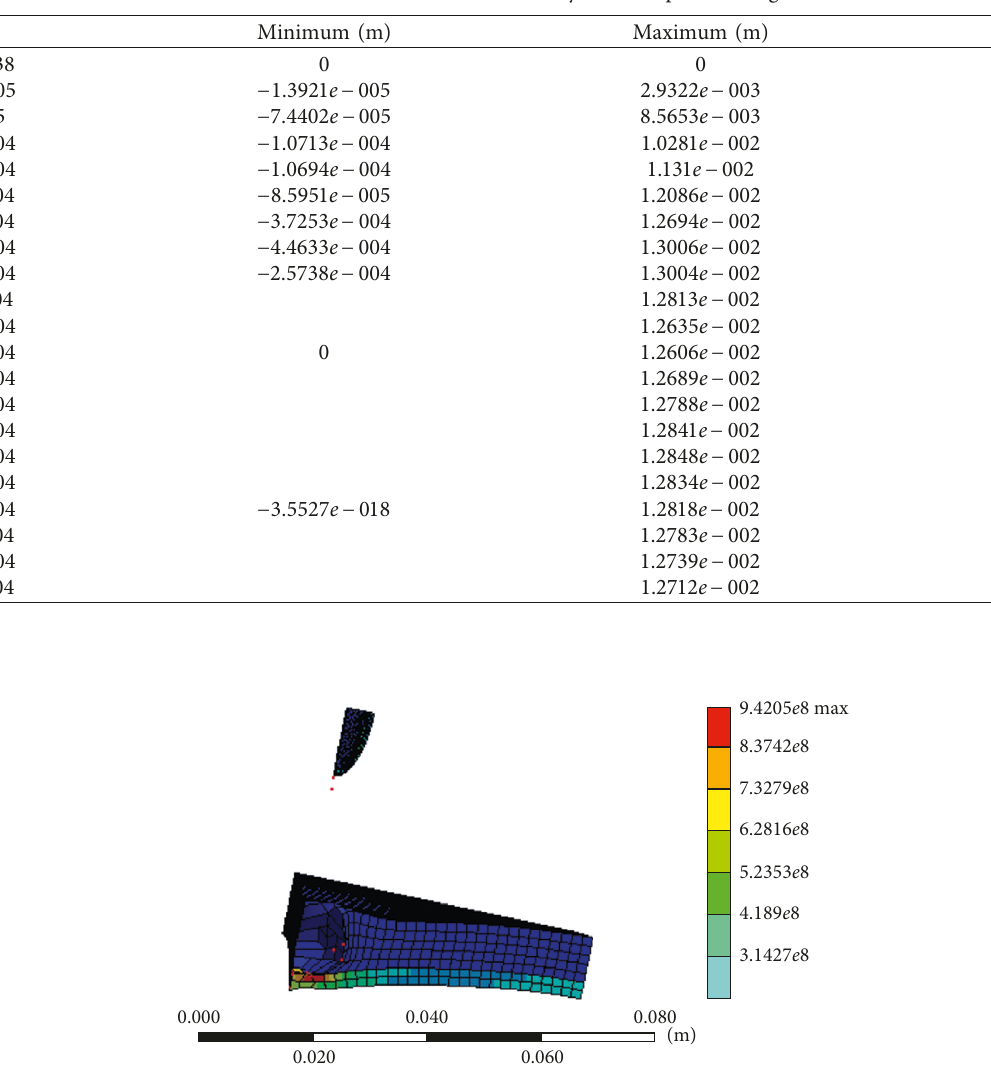
Table 8: Directional deformation in Z direction of steel layer of sample 1 during the time of simulation.